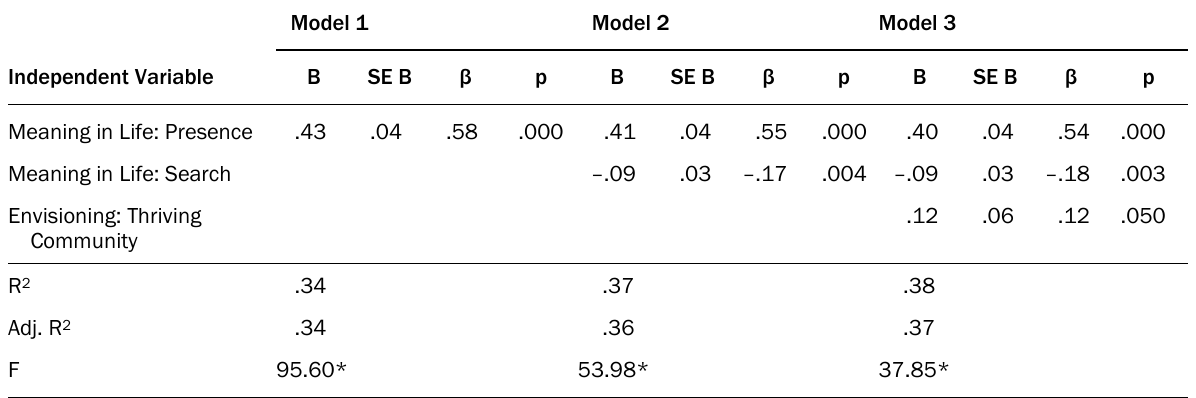
Table A6. Dependent Variable: Psychological Well-Being Behavioral Aesthetics Model 1 Model 2 Model